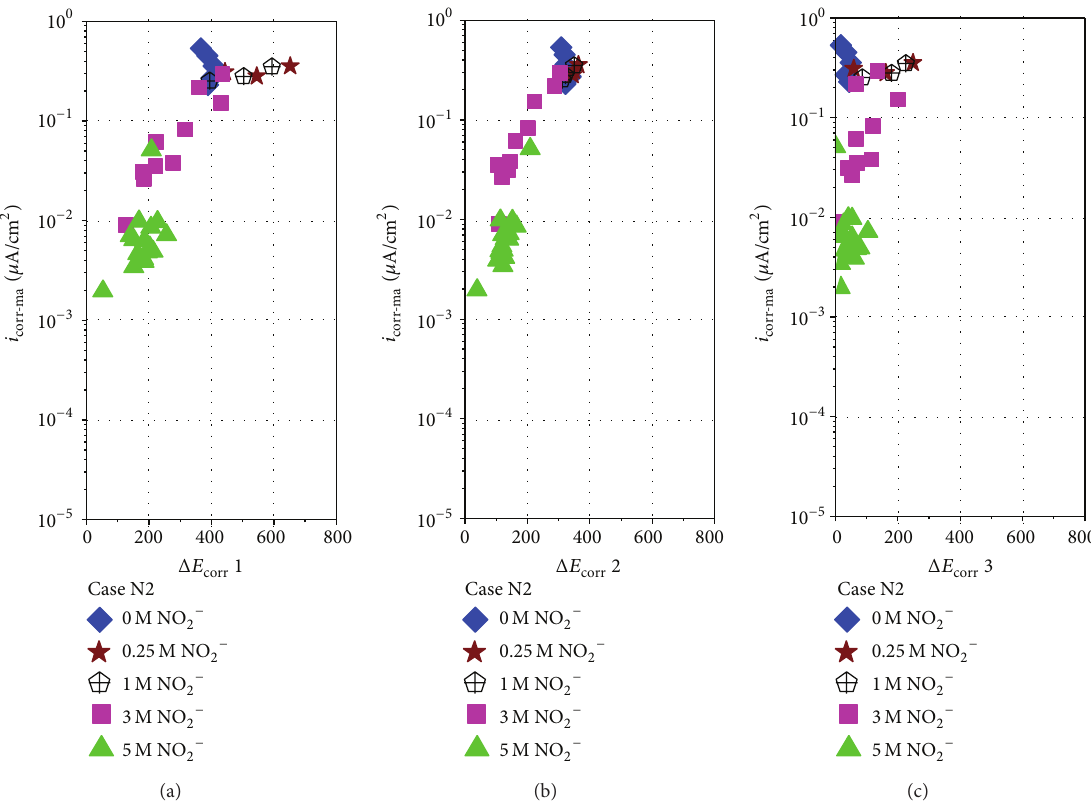
1 and macrocell current density, (b) relationships between corr 3 and macrocell current density, for the Case corr